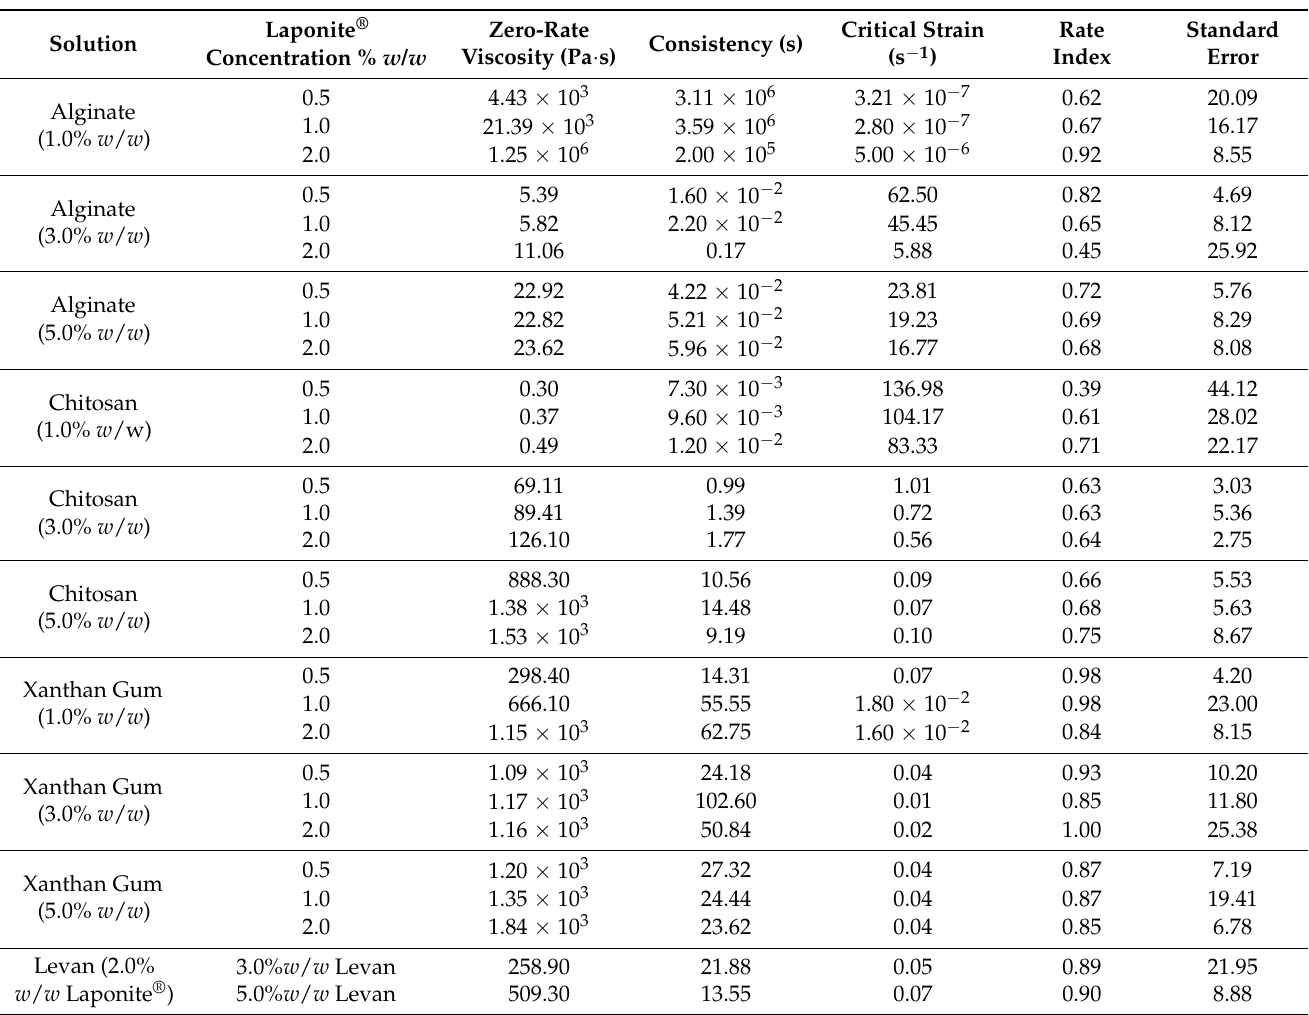
Table 2. Cross fit results (with Laponite ®